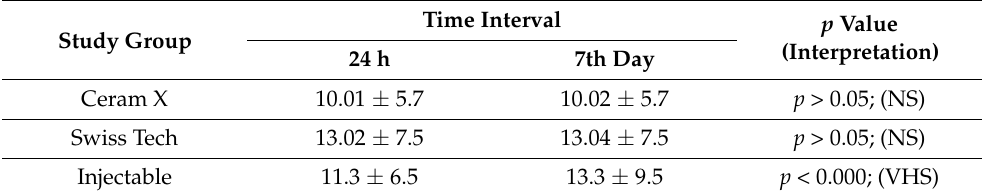
Table 3. Intragroup comparative evaluation of the monomer elution from three resin composites at different time